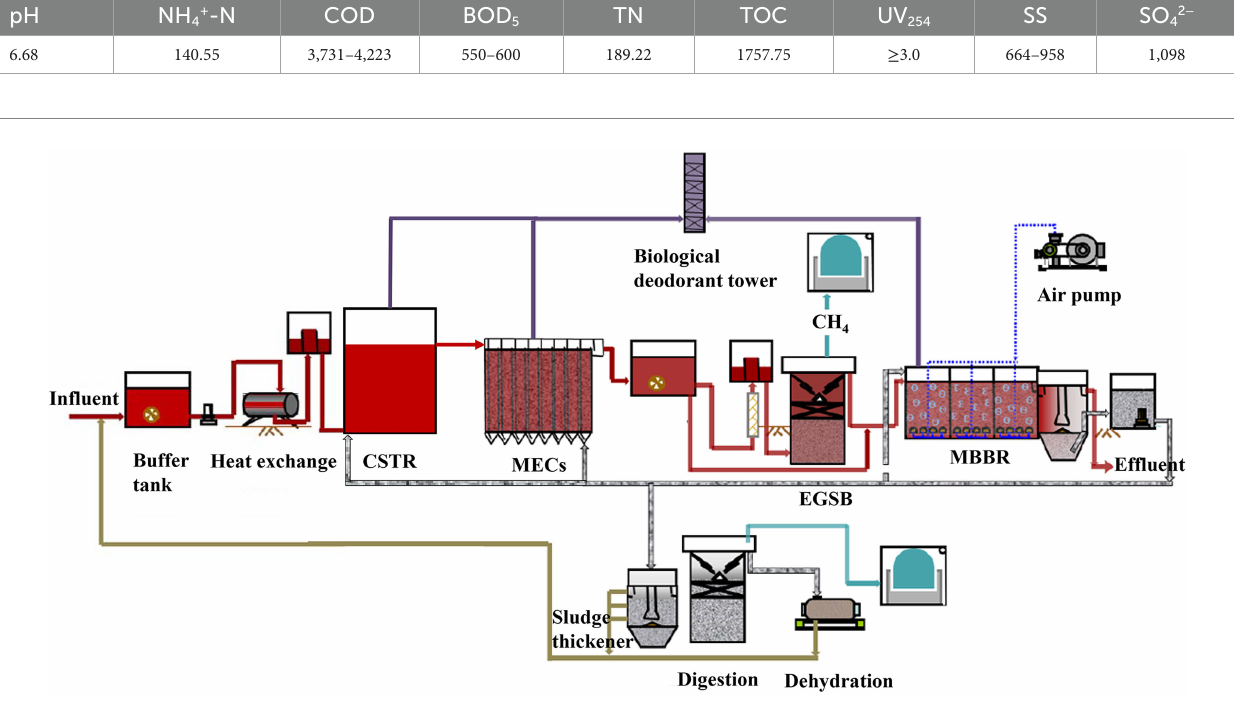
FIGURE 1 Flowchart of the integrated process of CSTR + MECs + EGSB +